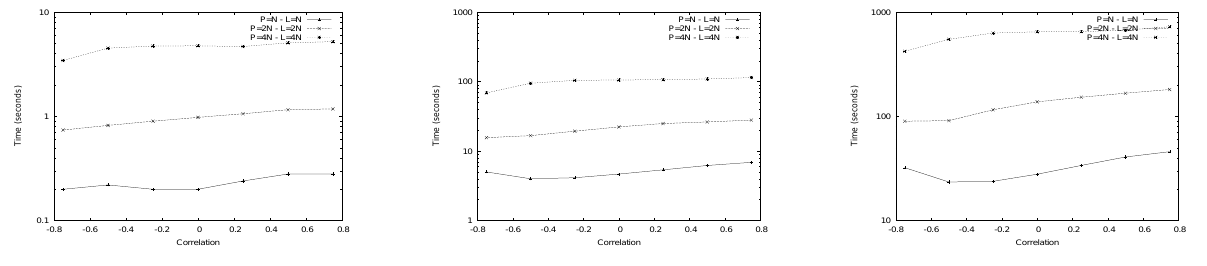
Figure 2: Mean computation time for HyMOGWW, instance sizes 25, 50, and